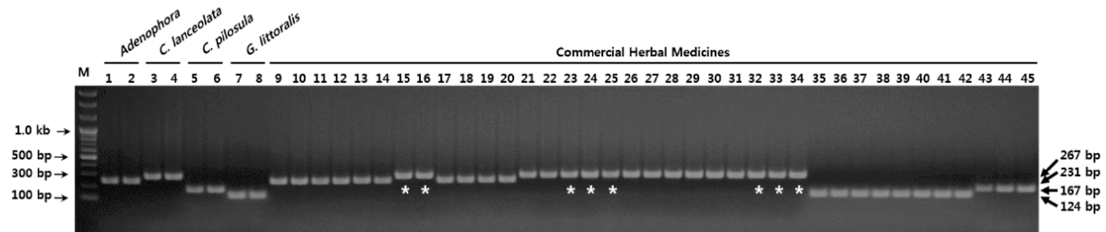
Figure 4. Monitoring of commercially processed herbal medicines using the multiplexed SCAR assay. Lanes 1–8: control plant materials used to develop SCAR markers. Lanes 9–45 correspond to the numbers 1–37 listed in Table 4, which are commercially-processed herbal medicines purchased from Chinese and Korean herbal markets. The precise lengths of DNA fragments are indicated to the right side of the gel images. M represents the 100 bp DNA ladder. Asterisks (*) mark the inauthentic commercial herbal medicines. Table 4. Sample information and monitoring results of the 37 commercial herbal medicines assessed using our multiplexed SCAR assay.